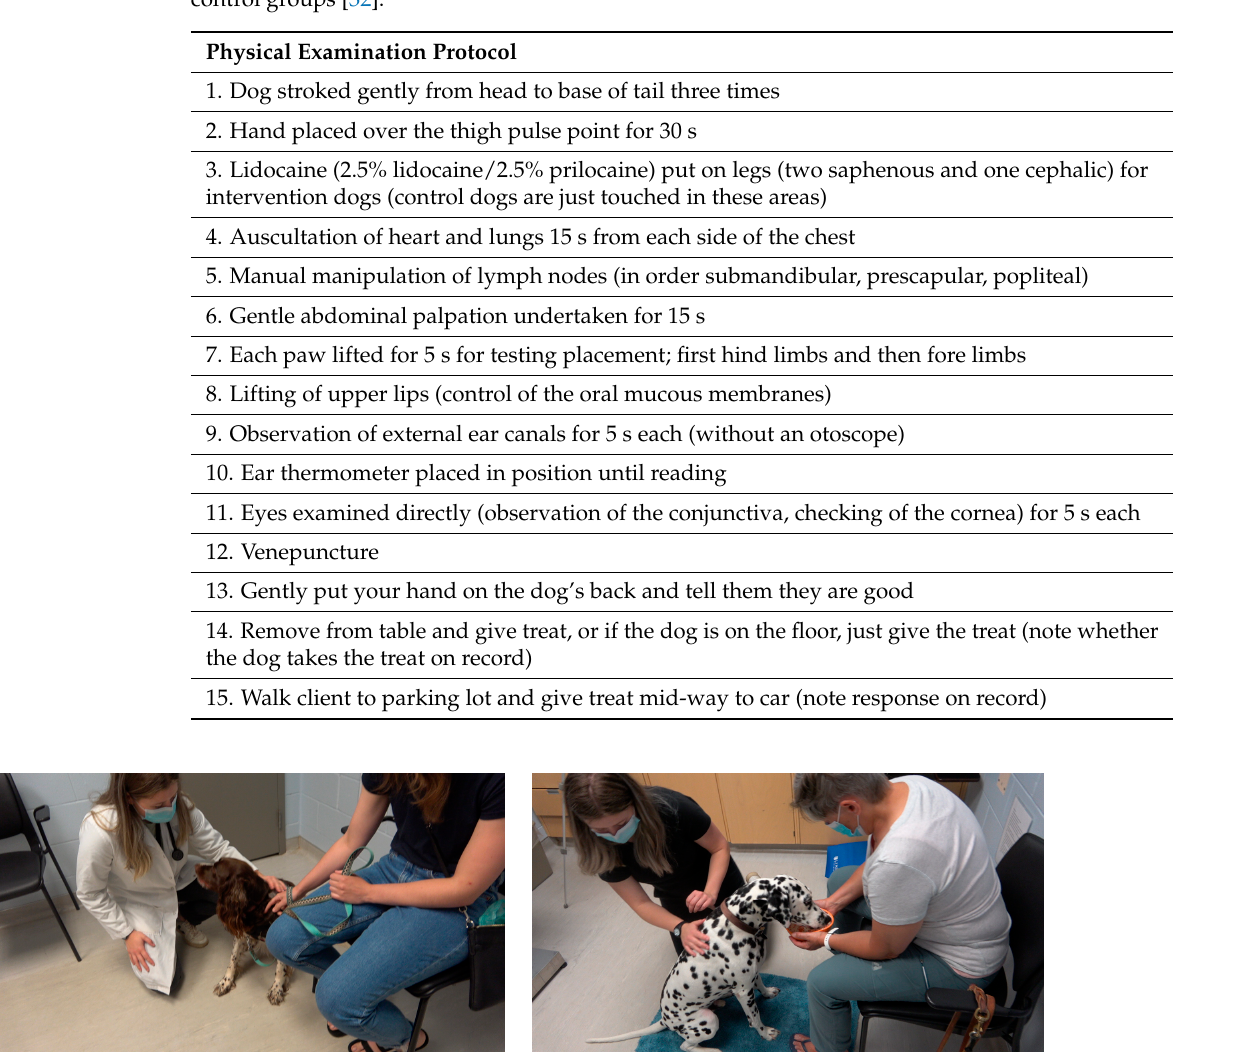
Table 3. Exam structure—including order and timing or frequency—used for both intervention and control groups [32].